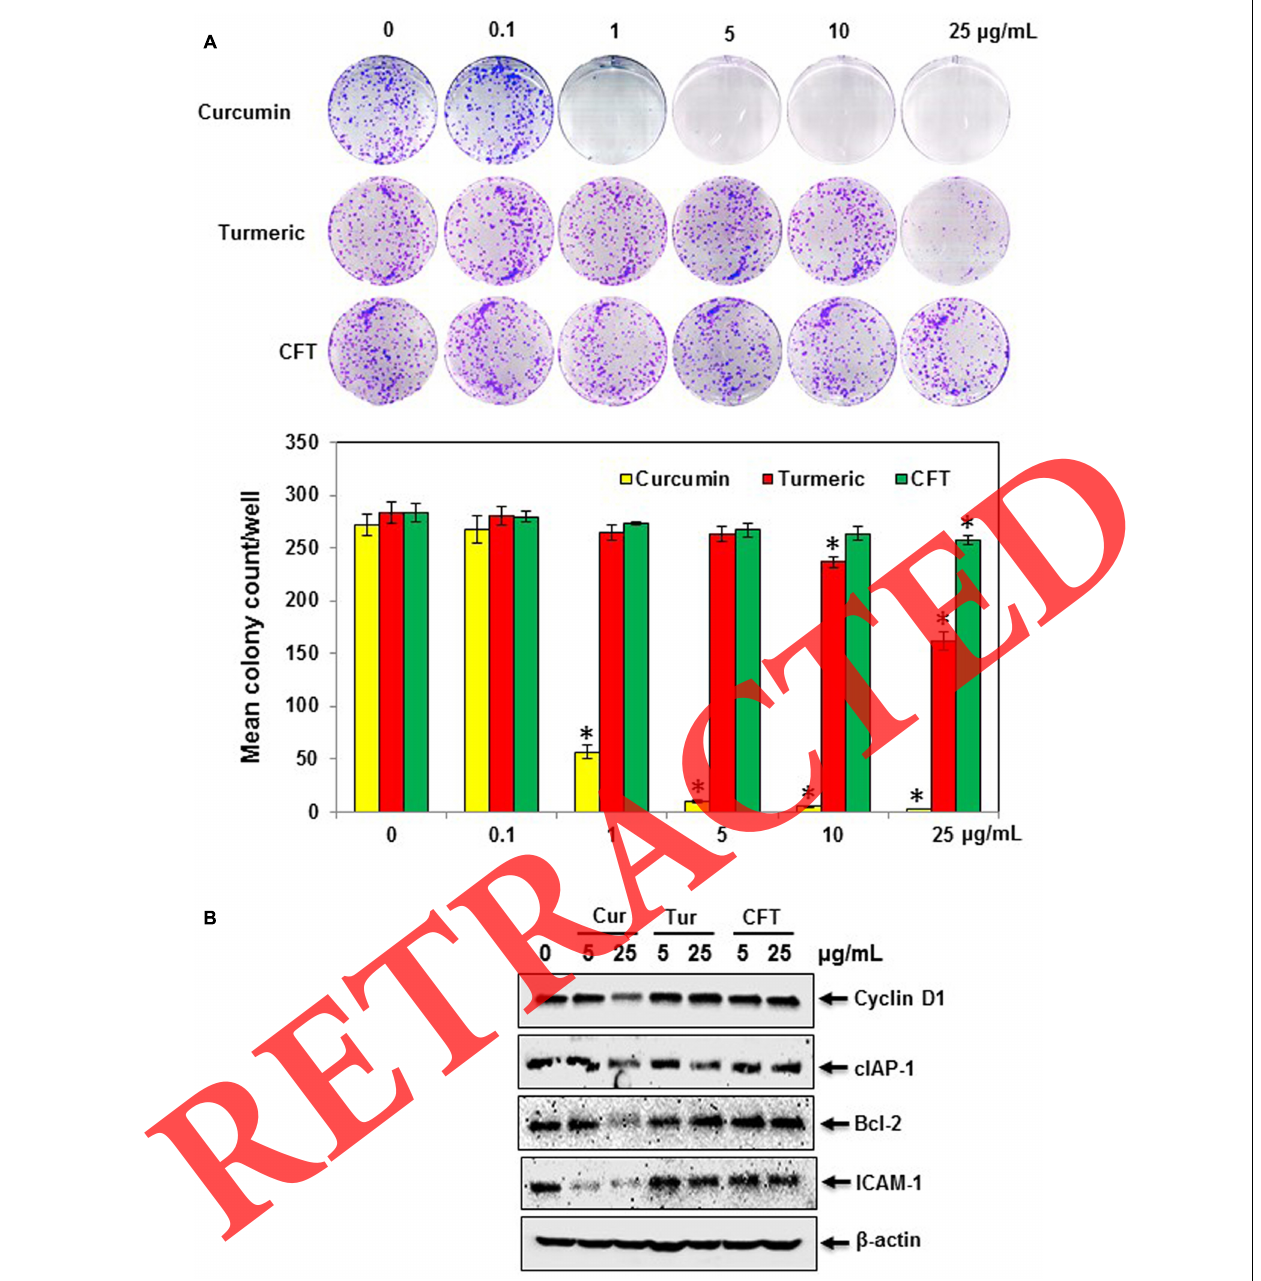
FIGURE 2 | Curcumin inhibits colony formation and modulates cell survival, proliferative and metastatic proteins to a greater extent than CFT and turmeric. (A) HCT-116 cells (1000/well) were treated with different concentrations of curcumin, turmeric and CFT for 12 h, then rinsed in PBS to remove the agent, and incubated in fresh medium. After 9 days, the cells were stained with crystal violet (upper panel) and the number of colonies counted (lower panel). N = 3; ∗ P < 0.05. (B) HCT-116 cells (1 × 10 6 /well) were treated with indicated concentrations of curcumin, turmeric, and CFT for 24 h and then harvested. Whole cell lysates were prepared and subjected to Western blotting to analyze cyclin D1, cIAP-1, Bcl-2, and ICAM-1 protein expression. The same blots were then stripped and reprobed with β -actin antibody to verify equal protein